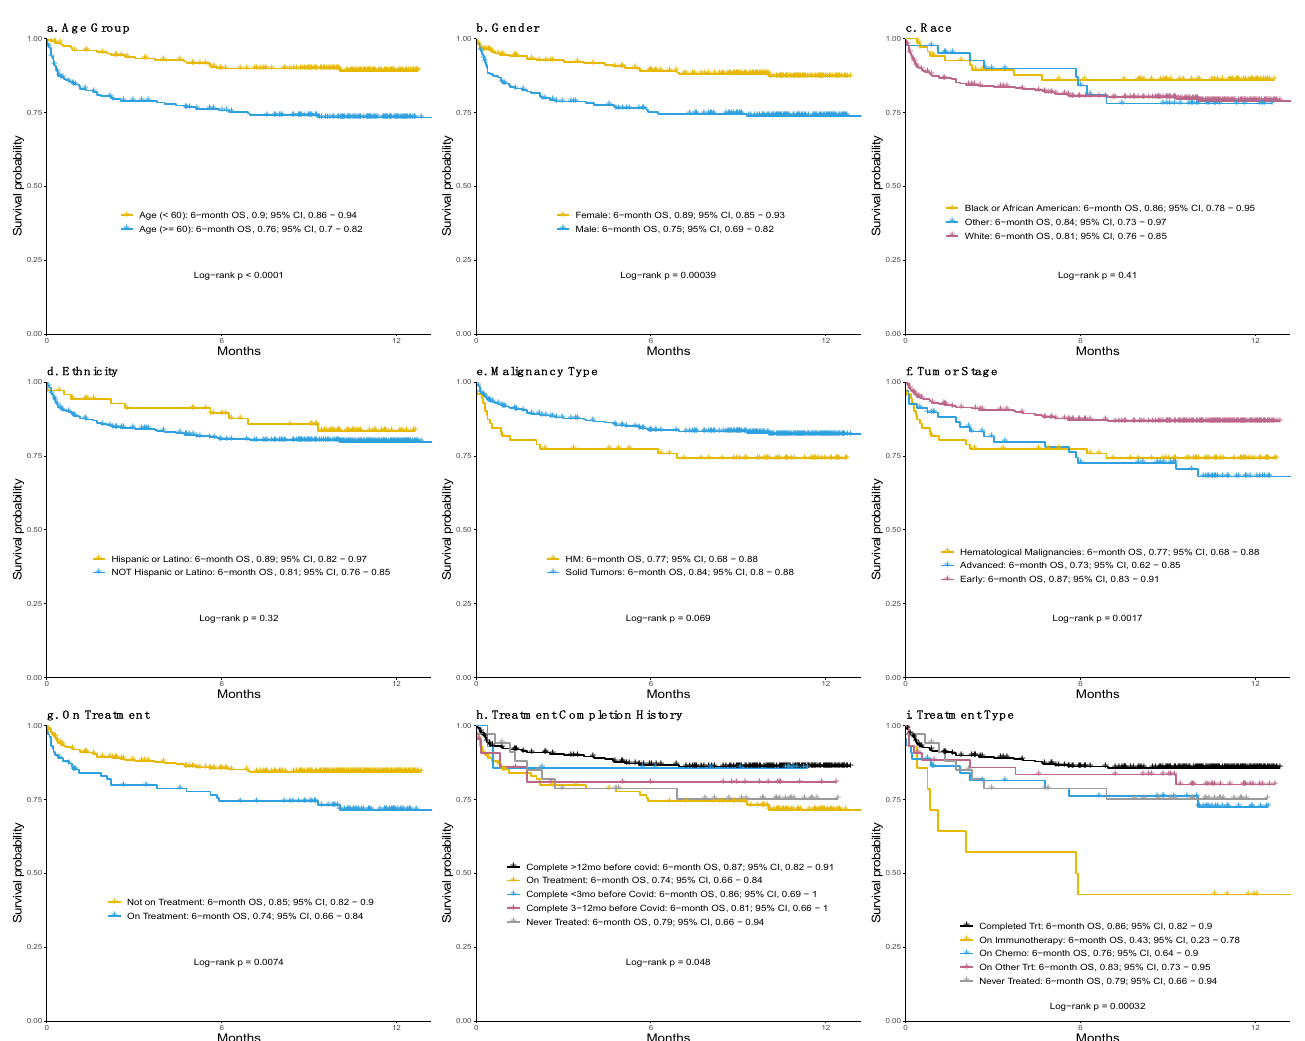
Figure 1. Overall survival by age group ( a ), gender ( b ), race ( c ), ethnicity ( d ), malignancy type ( e ), tumor stage ( f ), active treatment ( g ), timeline of treatment completion ( h ) and type of treatment ( i ).